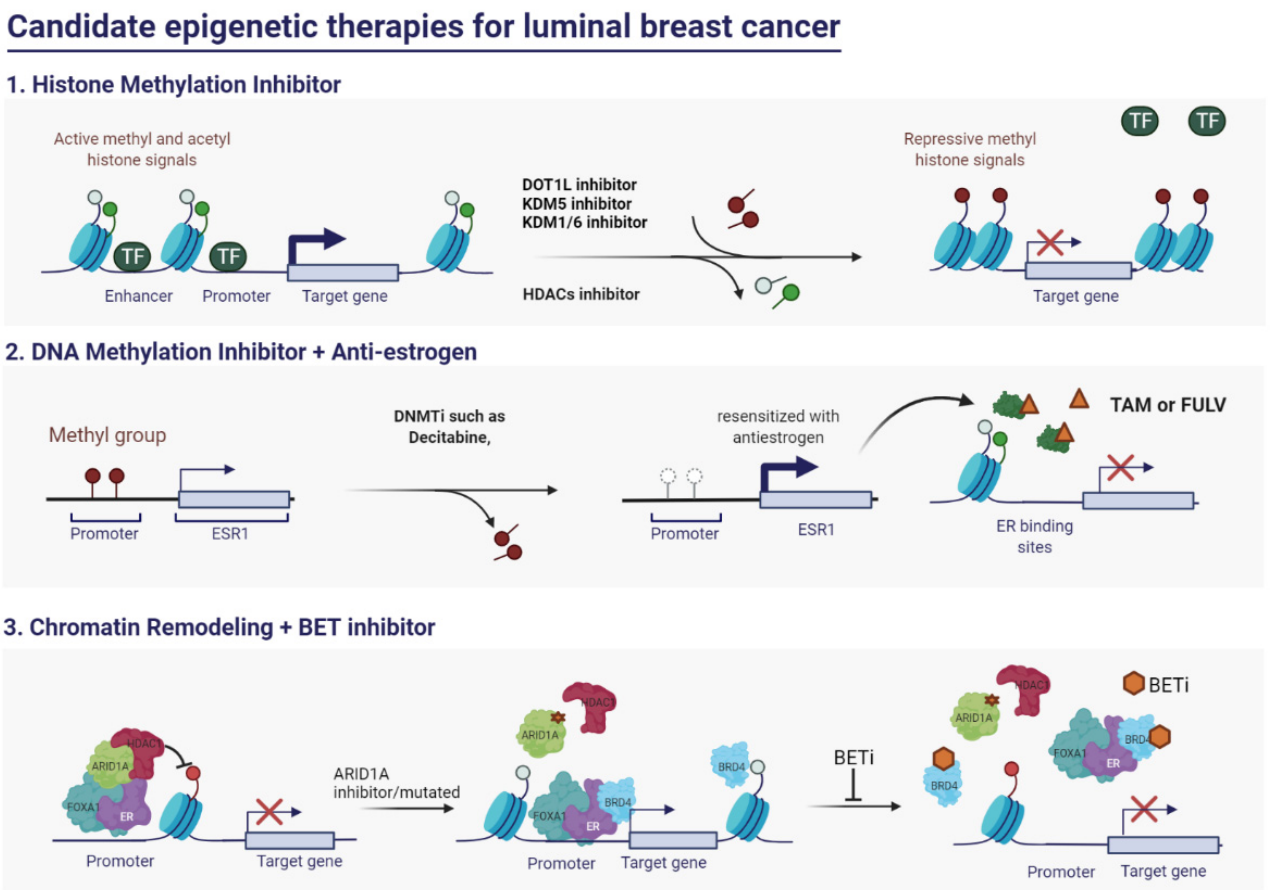
Figure 2. Epi-drugs used in luminal breast cancer therapy: ( 1 ). Histone methylation inhibitors exhibit growth-inhibitory effects against luminal breast cancer by suppressing estrogen receptor (ER)-alpha (ER α ) function and expression. DOT1L (H3K79 methylation), KDM5/KDM1 (H3K4 demethylation), and KDM6 (H3K4 and H3K27 demethylation) inhibitors have been evaluated as potential therapeutics for ER-positive breast cancer. ( 2 ). The sensitivity of luminal breast cancer with downregulated ER expression to anti-estrogen therapy can be potentiated by co-treatment with DNA methylation inhibitors. ( 3 ). Mutations in the chromatin remodeler lead to alterations in chromatin landscape and gene expression in luminal breast cancer. For example, ARID1A mutation switches HDAC1-mediated gene suppression to BRD4-mediated gene activation. Therefore, BET inhibitors can be effective against ARID1A-deficient luminal breast cancer. TF, transcription factor; DNMTi, DNMT inhibitor; TAM, tamoxifen; FULV, fulvestrant; BET, Bromodomain and Extra-Terminal motif. The figure is created by the BioRender